Question: Provide a publication-style caption for this figure.
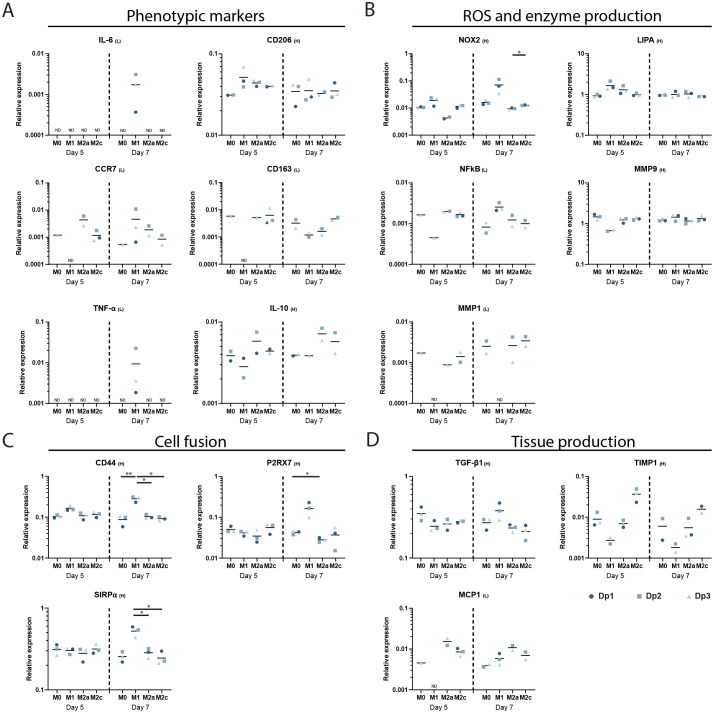
Answer: Effect of macrophage polarization on foreign body giant cell (FBGC) polarization. Genes related to phenotype (A) , reactive oxygen species (ROS) and enzyme production (B) , cell fusion (C) , and tissue production (D) were measured. Gene expression relative to housekeeping genes. ( H ) and ( L ) depict dilution of cDNA by 60x or 30x respectively. Samples depicted with ND showed no signal or too high variability between technical replicates. Day 5 represents five days of interleukin-4 (IL-4) induced fusion after polarization and day 7 represents two days of re-polarization of FBGCs. All lines in the figures show mean value with each shape representing a different donor pool (Dp1-3; n=3 biological replicates). * p < 0.05.